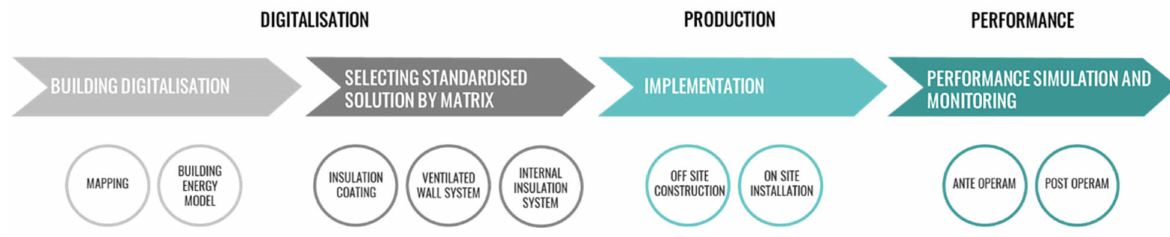
Figure 1. Methodology flow chart to promote the optimisation of the entire construction sector industrial